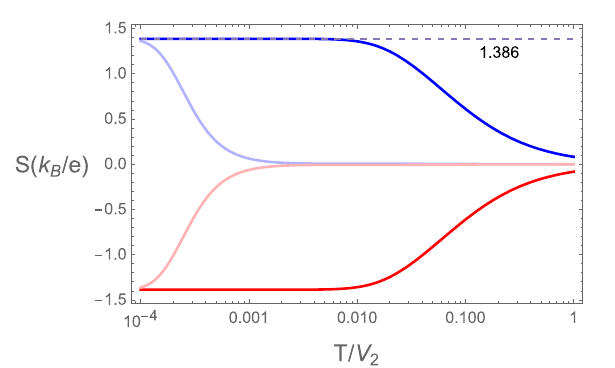
Figure 6. Thermopower of the device as a function of temperature in units of ( k B / e ) at the topological transition of the RM chains. S > 0 correspond to µ = ǫ = + 0.1 , and µ = ǫ = + 3.3 × 10 − Negative thermopower ( S < 0 ) corresponds to µ = ǫ = − 0.1 and µ = ǫ = − 3.3 × 10 − The light color curves show the trend to the results the SSH chain with ǫ = 0 . The energy scale for the low temperature saturation of the thermopower is given by the difference in site energies, 2 ǫ . The numerical results for the saturation values, S ( T = 0 ) ≈ ± 1.38634 are in close agreement with S 0 = ± 2ln 2 ≈ ± 1.38634 , as discussed in the